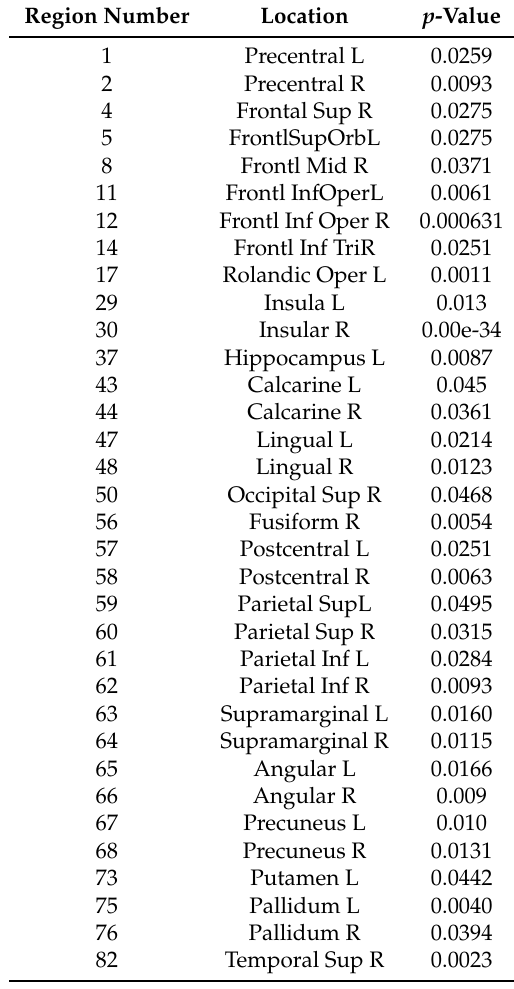
Table 2. Regions with a significant difference in grey matter volume between AD and HC that did not survive after Bonferroni’s correction.